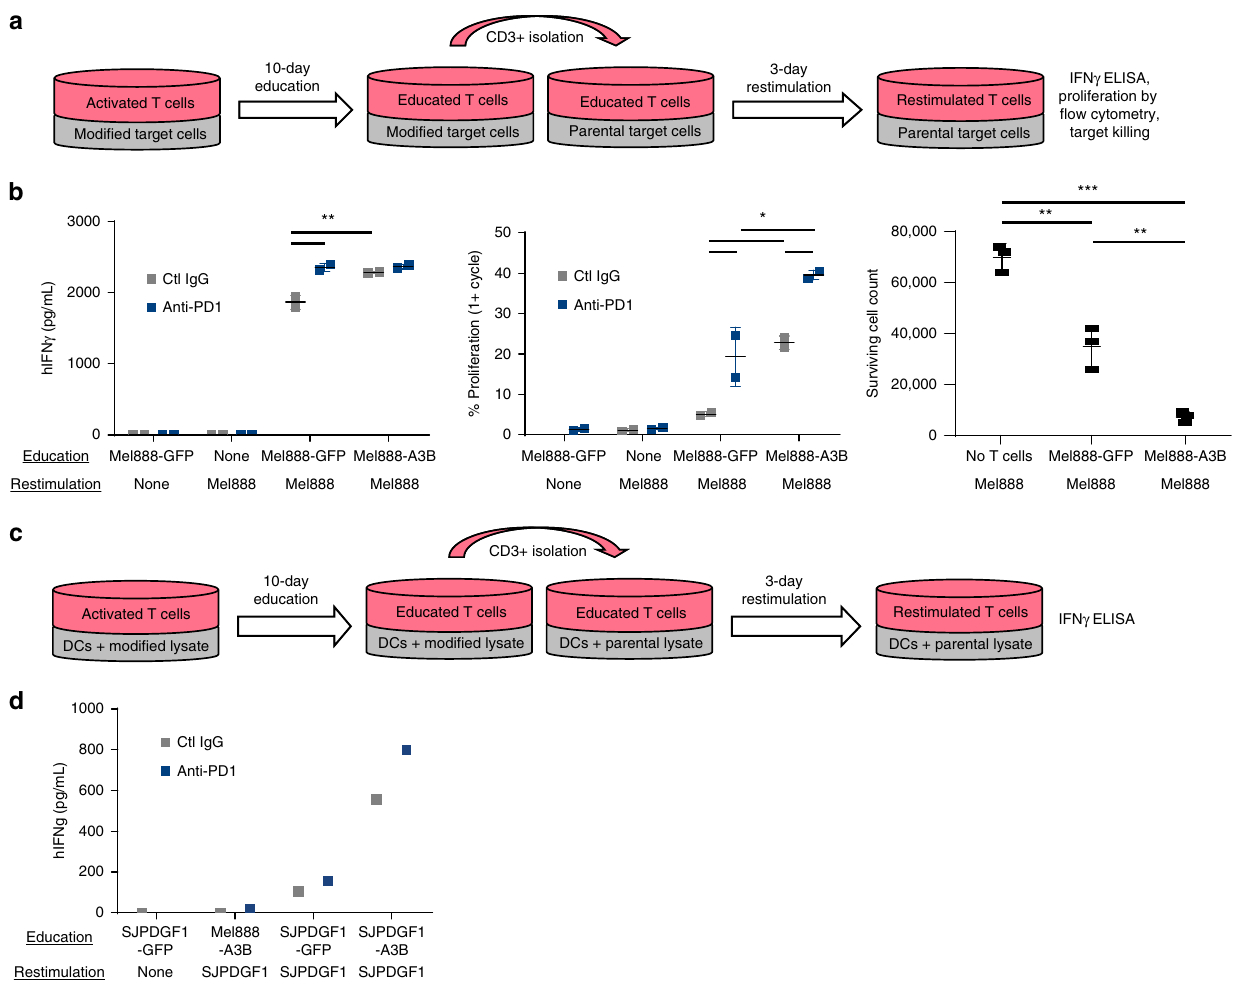
Fig. 6 Human reactivity to APOBEC3B-modi fi ed tumors. a CD3 + T cells from healthy donor PBMCs were isolated and activated with CD3/CD28 beads. These T cells were cocultured with Mel888 cells previously transduced by lentivirus expressing GFP or APOBEC3B and pretreated for 12 h with human interferon gamma (hIFN γ ). After 10 days of co-incubation, CD3 + T cells were isolated, stained with cell trace violet, and replated with hIFN γ pretreated Mel888 parental cells. After 3 days, supernatant was collected for hIFN γ ELISA, T cells underwent fl ow cytometric analysis for proliferation by cell trace violet dilution, and Mel888 cells were counted to assess target killing. Representative of three separate experiments. b hIFN γ ELISA, T-cell proliferation, and target killing from T cells cocultured with autologous Mel888 cells for both education and restimulation. Error bars indicate mean and SD. c Prior to coculture, CD14 + cells were isolated from healthy donor PBMCs and matured into monocyte-derived dendritic cells. CD3 + T cells were isolated from the same donor PBMCs and activated with CD3/CD28 beads. These T cells were cocultured with the mature dendritic cells and pulsed with pediatric glioma (SJPDGF1) or Mel888 lysate previously transduced by lentivirus expressing GFP or APOBEC3B. Lysates were added again on days 2 and 3 of coculture. Seven days later, CD3 + T cells were isolated, and cocultured with fresh monocyte-derived dendritic cells pulsed with parental SJPDGF1 lysate. Three days later, supernatant was collected for hIFN γ ELISA. d hIFN γ ELISA from vaccination using Mel888 or SJPDGF1 lysate for education and SJPDGF1 lysate for restimulation. All cocultures were performed at a 10:1 ratio of targets:effectors. Student ’ s t test was performed followed by Holm – Bonferroni correction